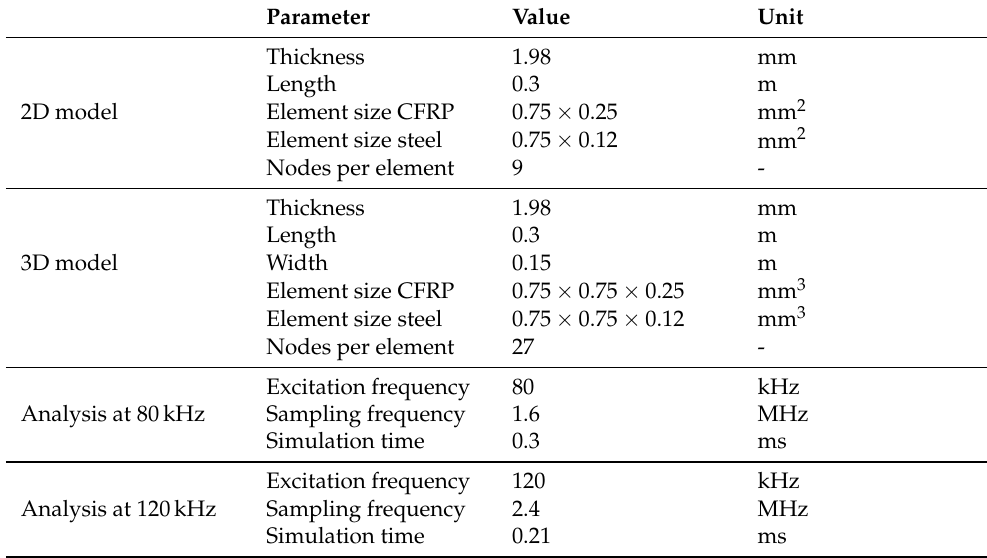
Table 3. Parameters of the numerical models and simulations for the computation of displacement